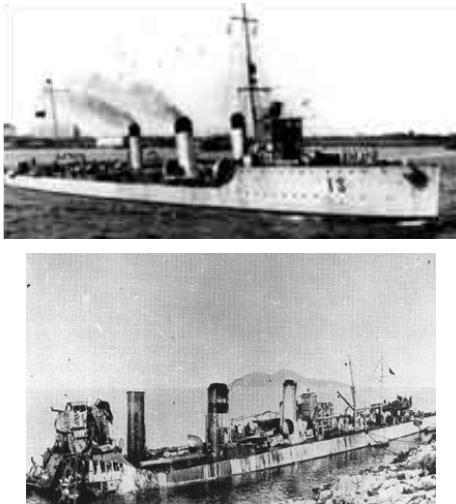
Figure 2: Historic photographs of “ three pipes ” ships.